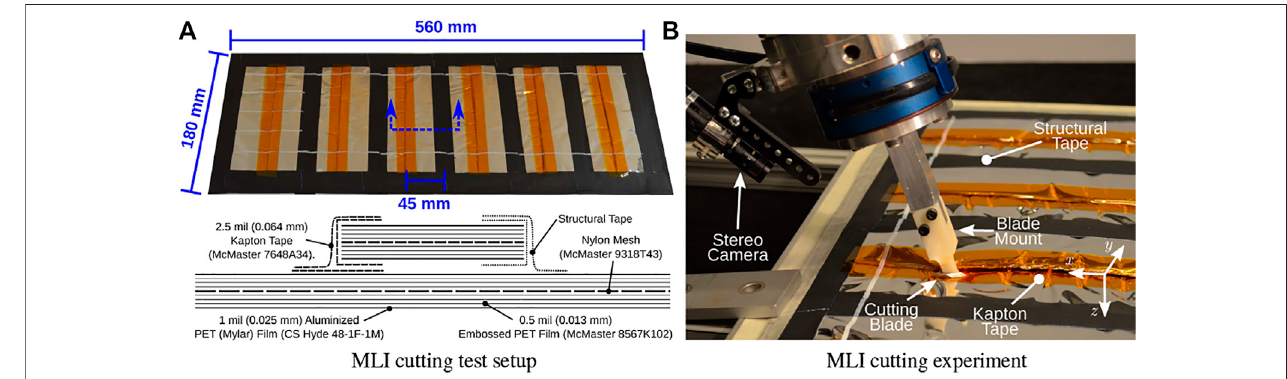
FIGURE 10 | Model-mediated teleoperation experiment from Vozar et al. (2015a). (A) MLI taping pattern, showing six test strips. One was used for practice (far left) , four were used for the trials (middle four) , and one (far right) was not used unless a spare was necessary. A schematic section view shows the structure of the blanket layers. (B) Closeup view of the blade apparatus cutting through Kapton tape on the satellite mock-up panel.